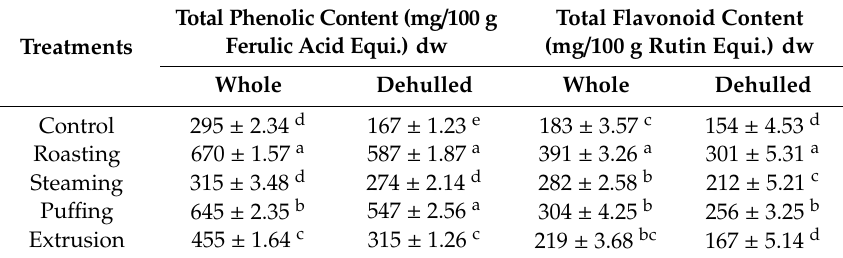
Table 1. Total phenolic and flavonoid content of processed broomcorn